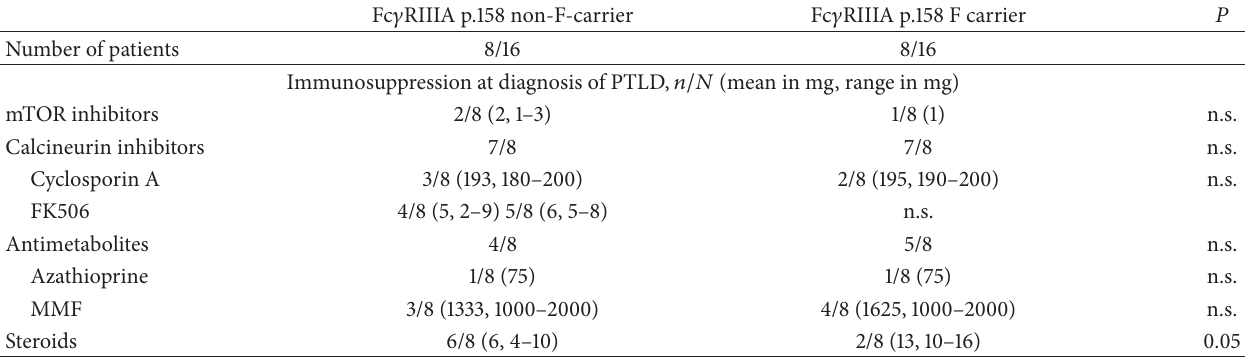
Table 3: Immunosuppression of patients treated in the PTLD-1 trial by Fc 𝛾 RIIIA p.158V/F polymorphism: non-F-carrier versus F carrier. Fc 𝛾 RIIIA p.158 non-F-carrier